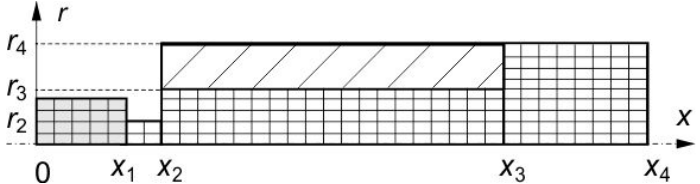
Figure 4. Partitioning of modeling area into cells (projection onto the x-r plane).